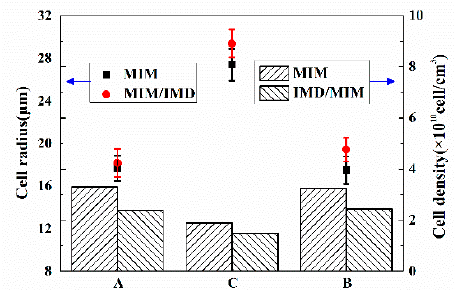
Figure 15. The cell radius and cell density of the transition layer A, core layer C and transition layer B of MIM and IMD/MIM samples.